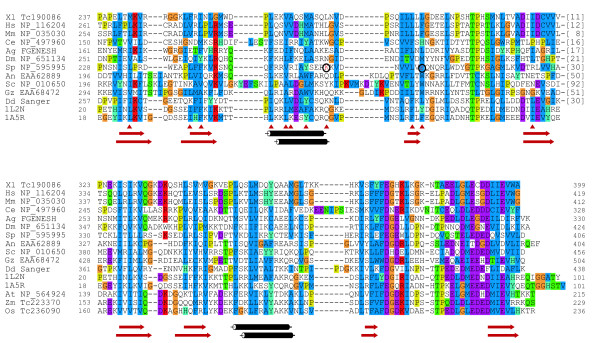
Multiple Sequence Alignment of Rad60-Esc2-NIP45 (RENi) members. The alignment is CLUSTAL colored [44]. The organism from which a sequence has been derived is indicated by a 2 letter code preceding the database accession numbers: An Aspergillus nidulans, Ag Anopheles gambiae, At Arabidopsis thaliana, Ce Caenorhabditis elegans, Dd Dictyostelium discoideum, Dm Drosophila melanogaster, Gz Gibberella zeae, Hs Homo sapiens, Mm Mus musculus, Os Oryza sativa, Sc Saccharomyces cerevisiae, Sp Schizosaccharomyces pombe, Xl Xenopus laevis, Zm Zea mays. All accession numbers can be found in the NCBI non-redundant database, except 1) the ones of Xl, Zm and Os, which correspond to the TIGR Contig identifiers from which a presumptive translation was derived 2) the Dd protein which is included in the Sanger protein set with the accession JC3V1_0C0008_11033 3) the Ag protein was derived using FGENESH on a segment from Anopheles gambiae str. PEST chromosome 2L (accession AAAB01008810) 4) IL2N, 1A5R are entries from the PDB. The two alignment blocks correspond to the two distinct SUMO-like domains in RENi proteins. Only the second block includes plant representatives, which seem to miss the first SUMO-like domain. The SUMO sequences IL2N, 1A5R have been aligned to both blocks and the secondary structure elements below the alignment are derived from the PDBsum entries for both of these. Triangles mark positions reported to be involved in maintaining the ubiquitin-fold of human SUMO-1 [21]. These are also highlighted in the structural representation in Figure 2. Black encycled red-colored residues in NP_595995 point at the mutations in the rad60-1 (K263E) [15] and rad60-3 (F272V) [20] variants.